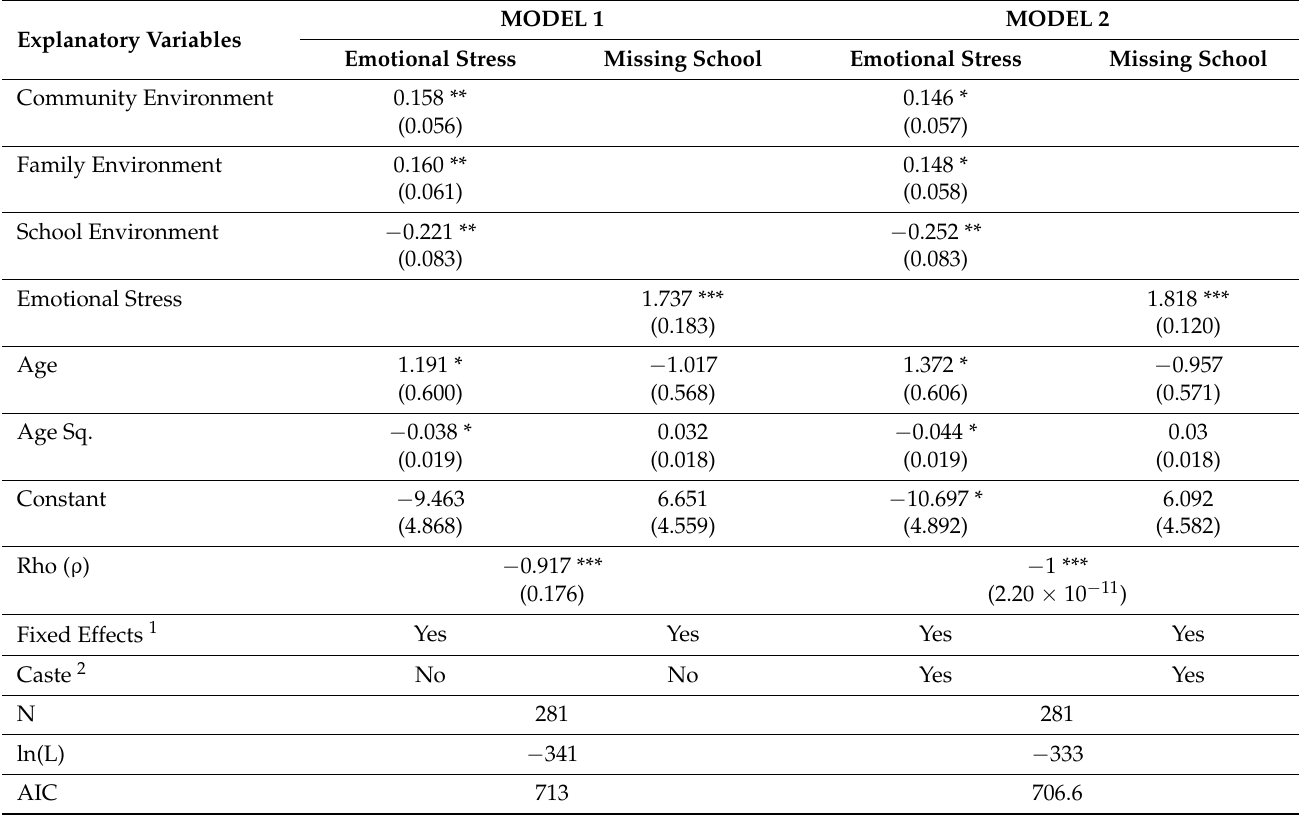
Table 3. Bivariate probit estimation of menstruation-related emotional stress & school absence 1 .